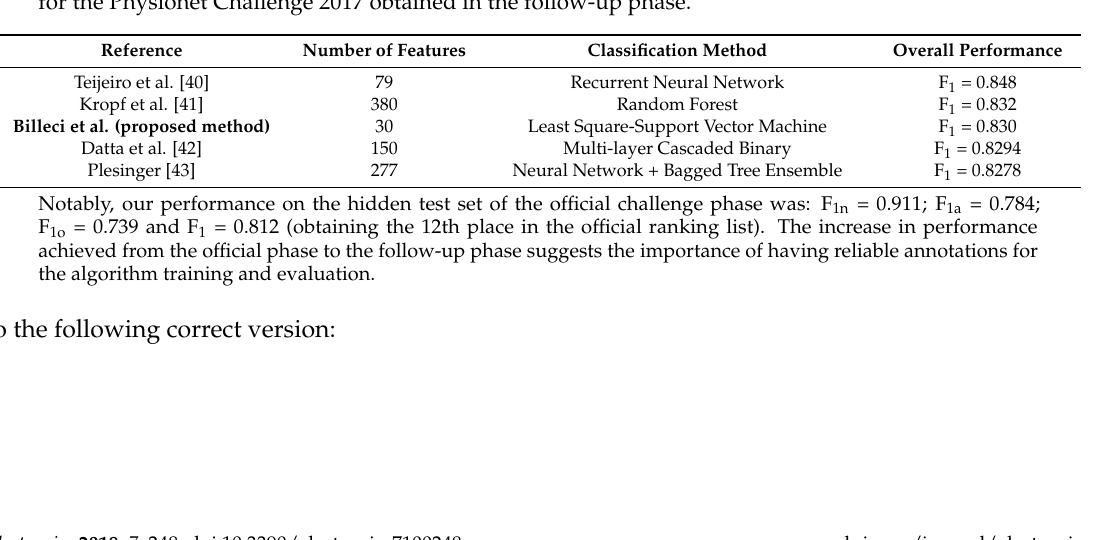
Table 3. Comparison of the results of the proposed methods with that of the other algorithms proposed for the Physionet Challenge 2017 obtained in the follow-up